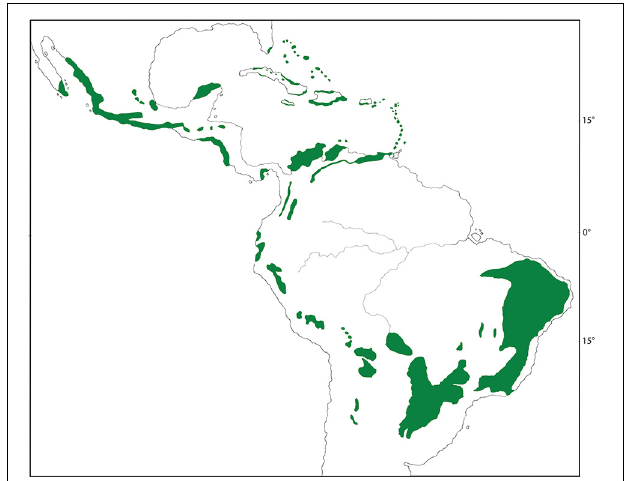
FIGURE 1 | Distribution of seasonal dry tropical forest (SDTF) across the New World (green). Distribution map is modified from Pennington et al.